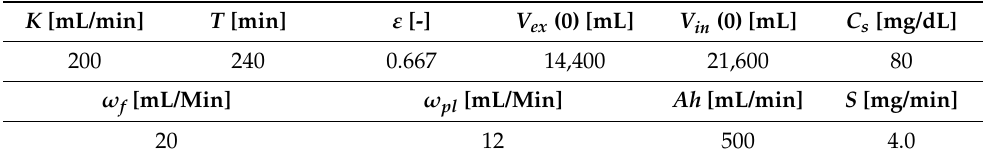
Table 1. Calculation conditions for